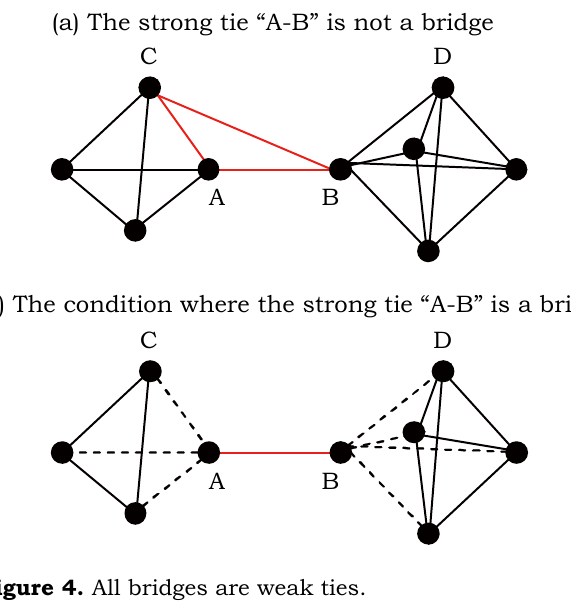
Figure 4. All bridges are weak